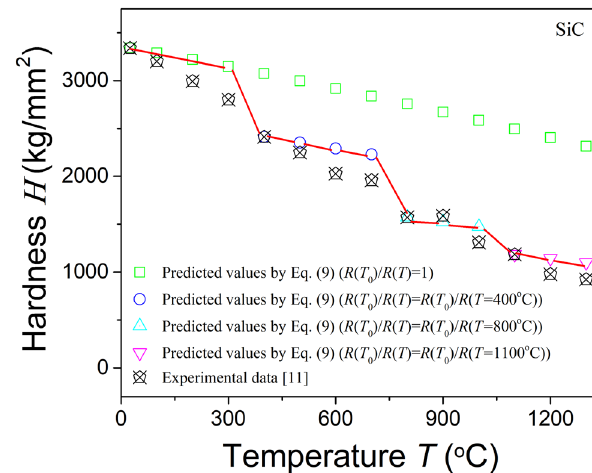
Figure 2: Comparison between the model - predicted and measured hardness of an Al 2 O 3 ceramic at high temperature.